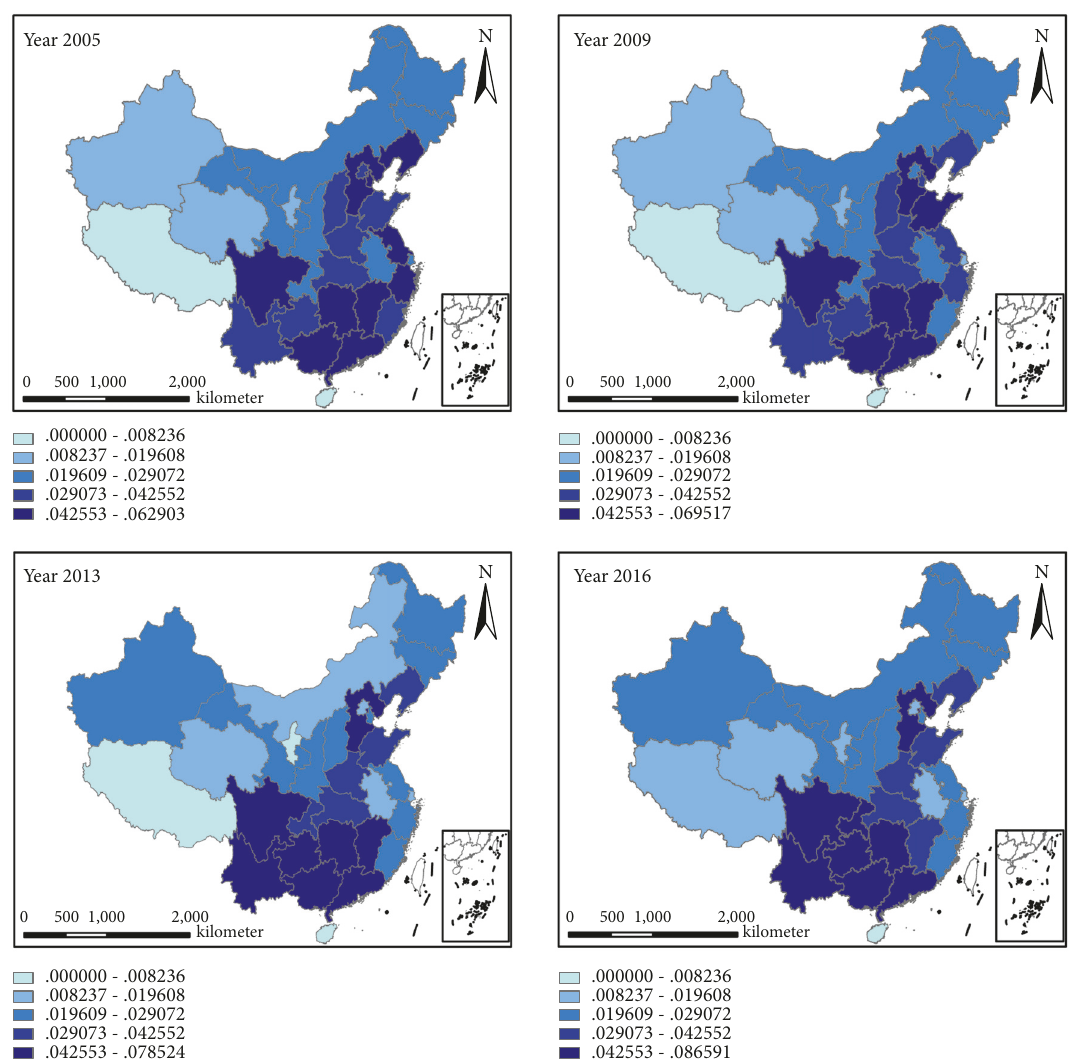
Figure 3: The evolution of PageRank from 2005 to